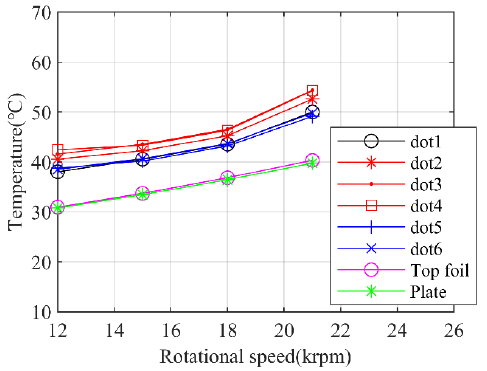
Figure 21. Relationship between bearing top foil temperature and rotational speed.